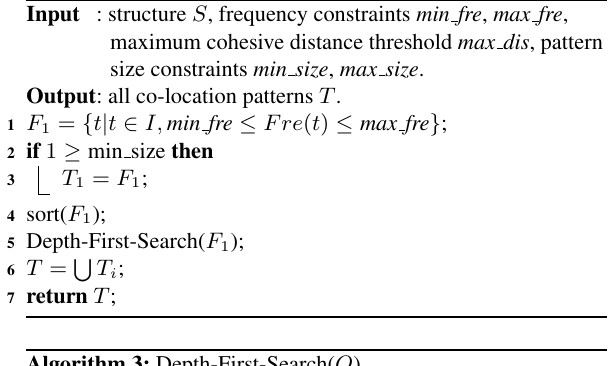
Algorithm 2: G ENERATING C OLOCATION P ATTERNS . An algo- rithm for generating all co-location patterns in a structure.